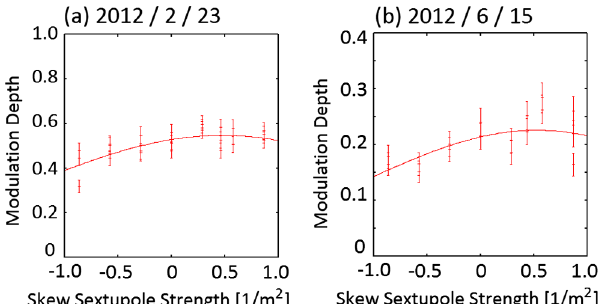
FIG. 9. The observed IP-BSM modulation dependence on the strength of the skew sextupole magnet